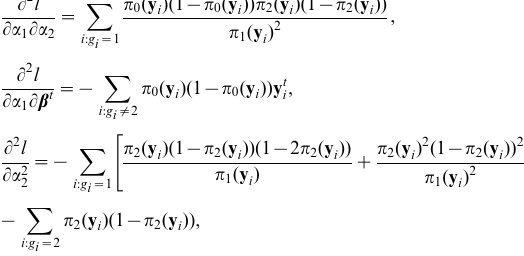
Penetrance ( K ) Frequency of Allele a ( p ) Significance Level Test Statistic